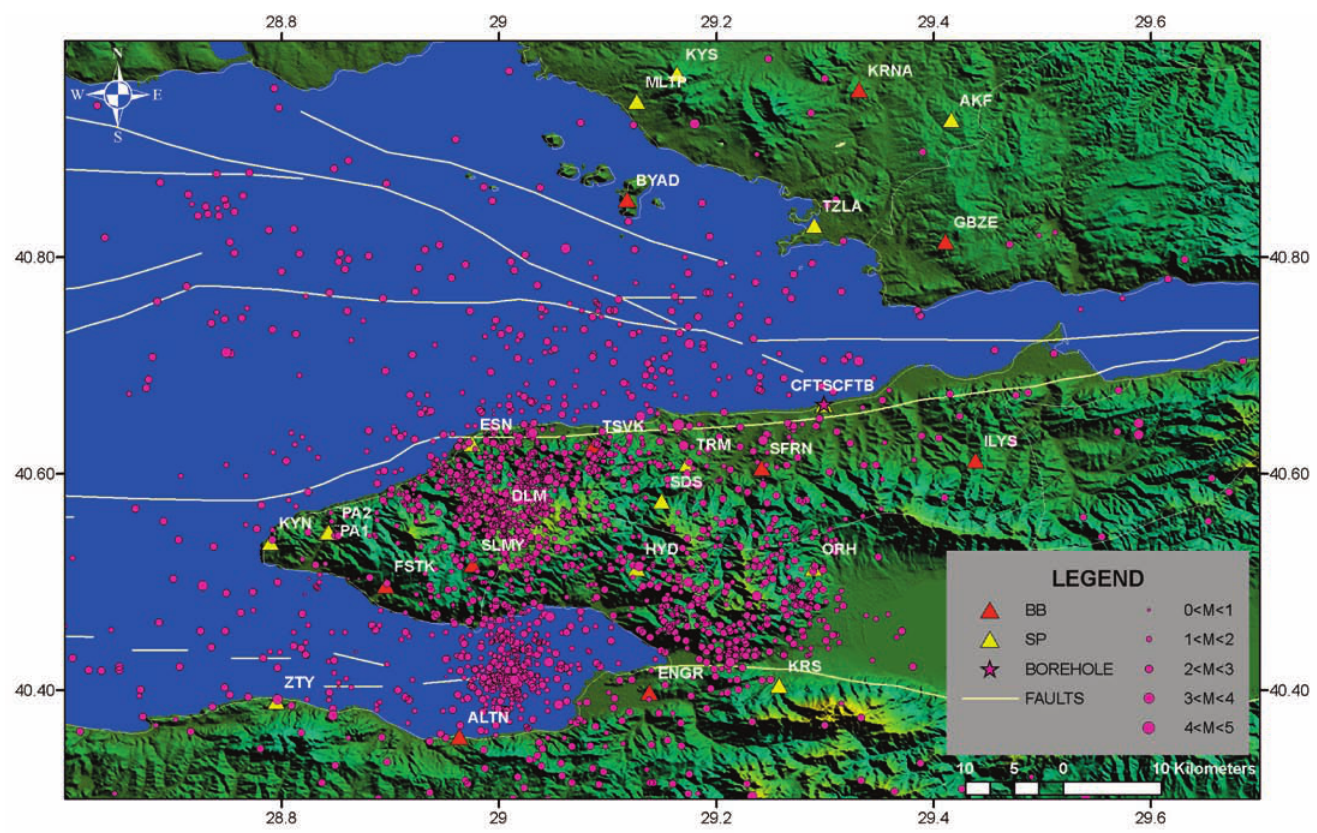
Figure 7. Seismicity of the Armutlu Peninsula. The earthquakes were recorded by the ARNET stations between October 2005 and August 2007, and from July to September 2009. Symbols as for Figure